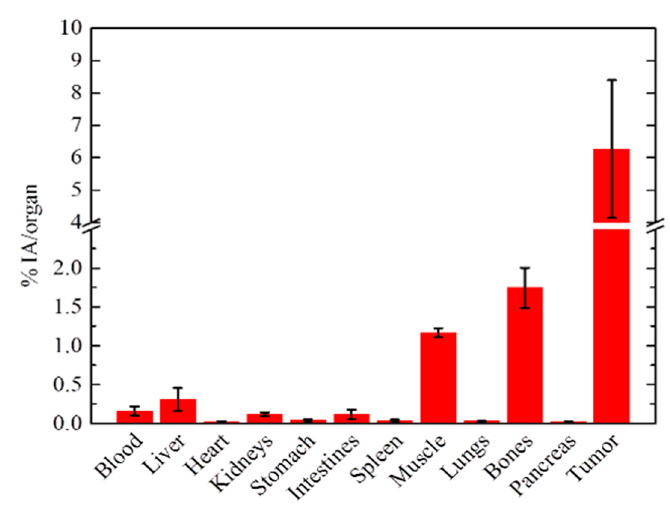
Figure 9. Ex vivo biodistribution data of 177 Lu@Fe 3 O 4 -CEPA-trastuzumab at 72 h p.i. in SKOV-3 tumor-bearing SCID mice, after intratumoral injection.